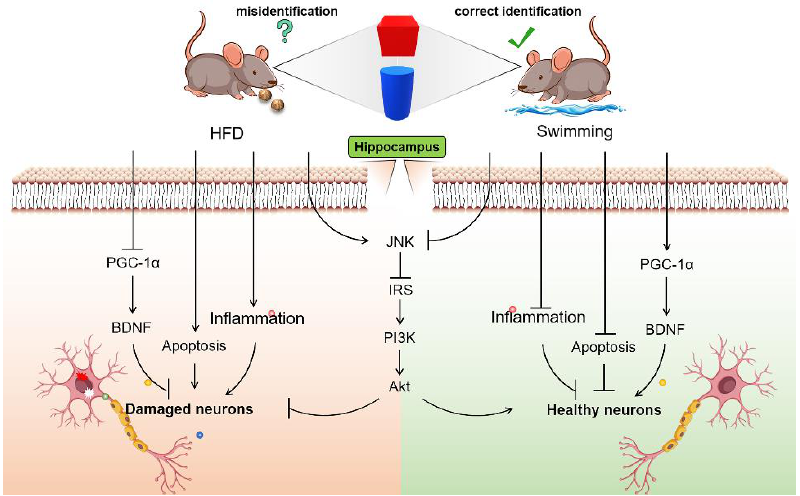
Figure 8. Swimming rescued the impaired cognitive capacity in adolescent mice caused by high-fat diets by suppressing inflammation, alleviating insulin resistance, up-regulating BDNF, and inhib- iting